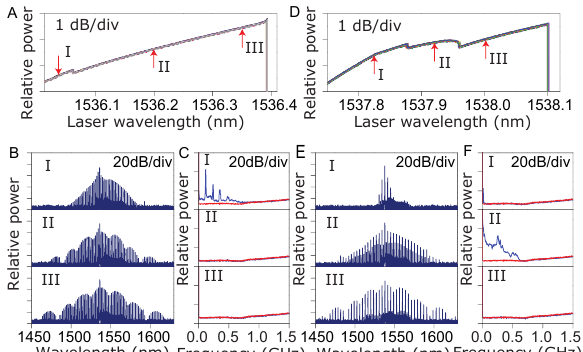
Figure 15: Low-noise, mode-locking transitions related to dark pulse formation. Two resonances close to mode-crossing position are pumped separately for A-C and D-F. (A), (D) Power transmission measured at the drop port. Twenty traces are overlaid with different colors. (B), (E) Comb spectra and (C), (F) intensity noise at differ- ent stages of comb development. The comb spacing is ~231